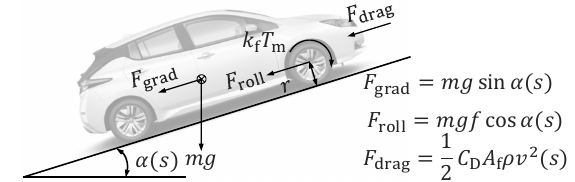
Figure 2. Schematic of longitudinal